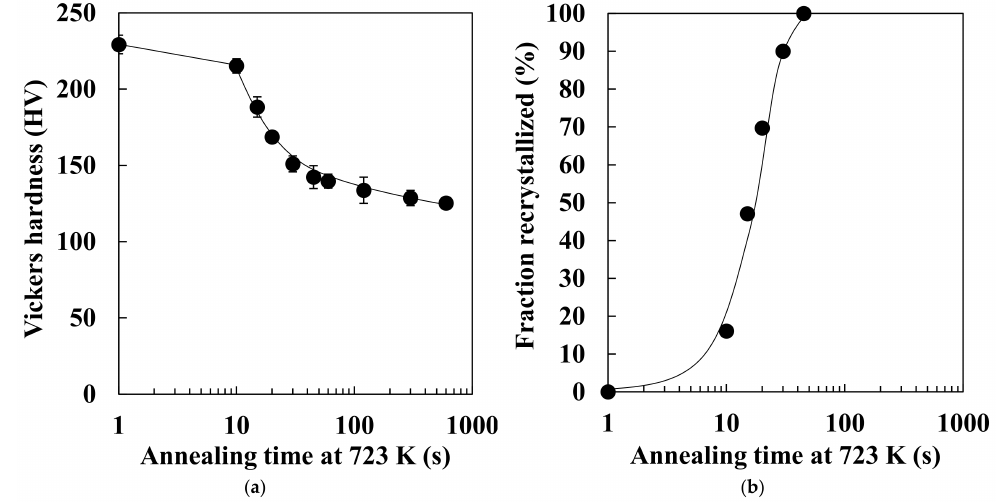
Figure 1. Changes in ( a ) Vickers hardness and ( b ) recrystallized fraction during isothermal holding at 723 K.